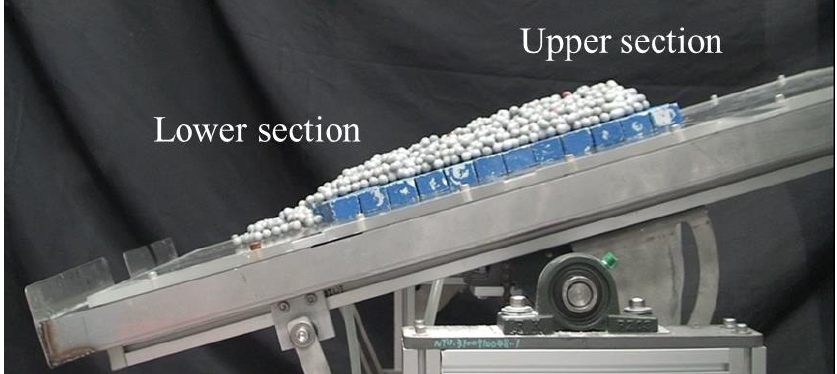
Figure 6. Schematic of specimen configuration.